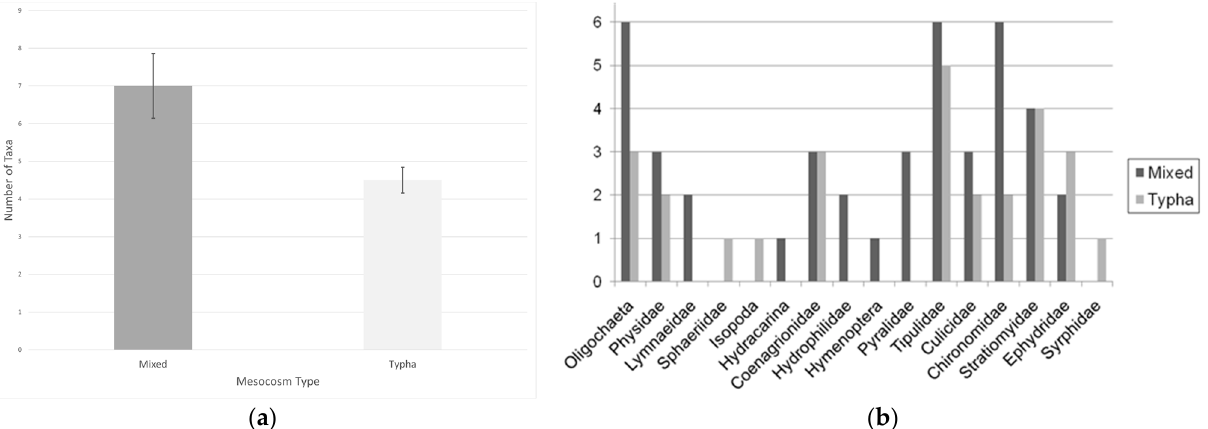
Figure 5. Epiphytic samples: ( a ) the number of taxa found (±standard error) compared is significantly different between mesocosm type (n = 8, p < 0.05); ( b ) number of epiphytic samples with a given taxon present by mesocosm type.